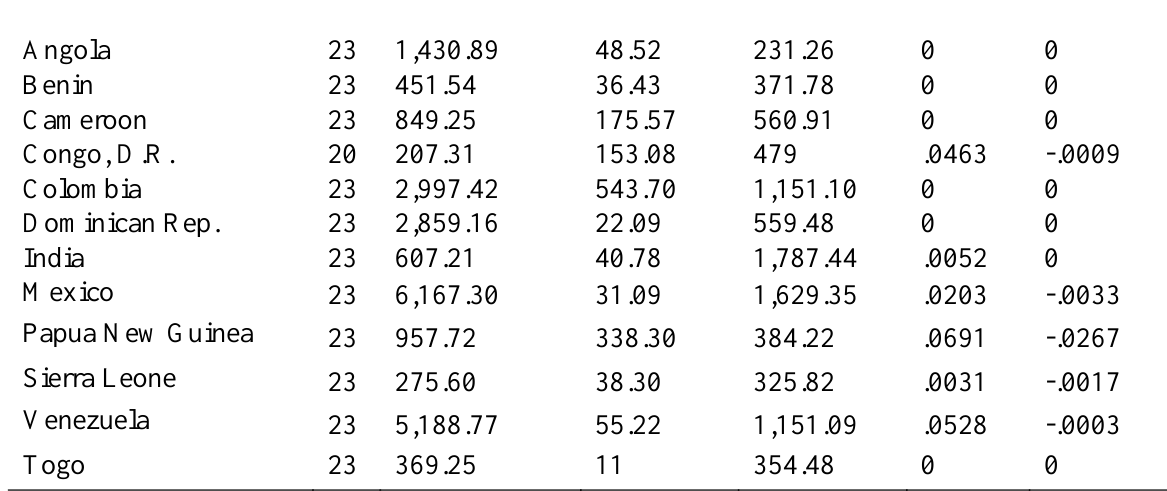
Table 2. Summary of Key Indicators for All Palm Oil Producers Mean